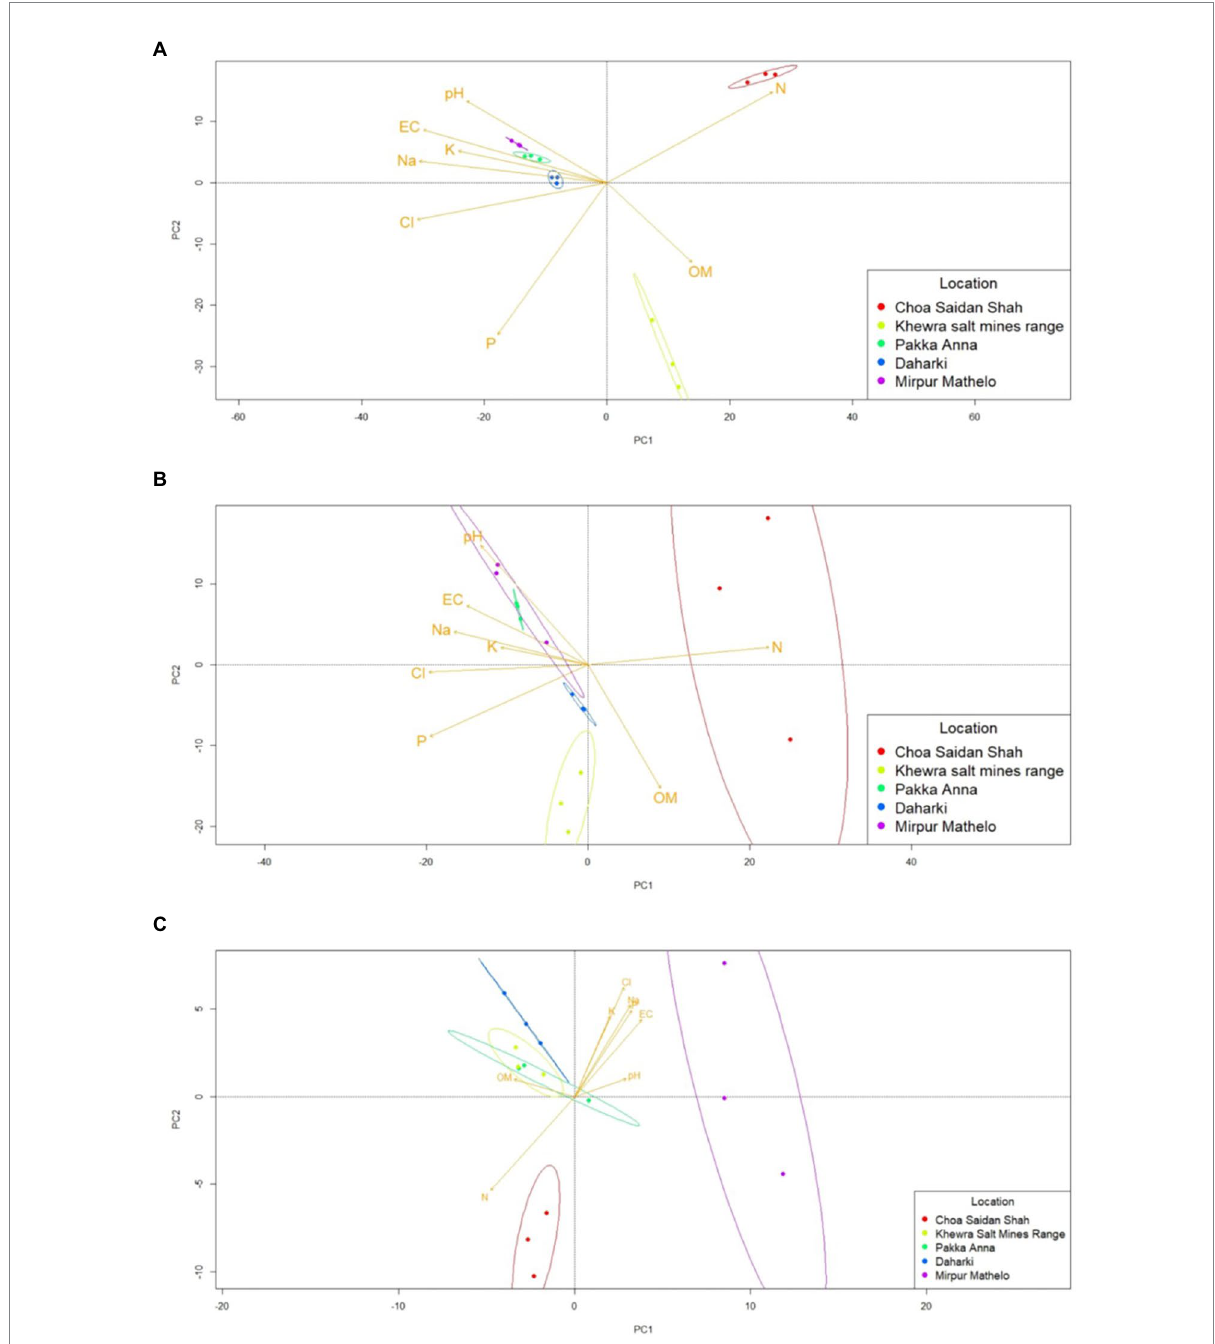
FIGURE 3 Differences in beta-diversity of soil microbial communities in five soils collected from agricultural fields within the Indus River Basin, Pakistan and correlations with chemical properties quantified using principal coordinates analyses (PCA). (A) bacteria; (B) nifH -containing bacteria; (C) acdS - containing bacteria; EC, electric conductivity; OM, organic matter; P, exchangeable phosphorous; CL, total concentrations of chloride; K, potassium; Na, sodium; N,